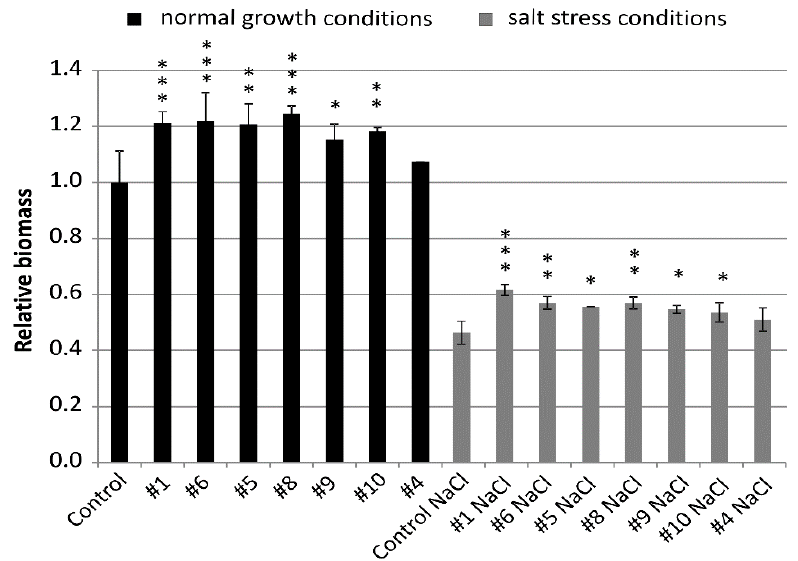
Figure 4. Relative biomass of the non-transgenic control and the transgenic plants of T 4 generation grown in normal (Hoagland medium) and in salt stress conditions (Hoagland medium supplemented with NaCl 200 mM). Data represent mean values and standard deviation of at least six plants grown in normal and salt stress conditions. Indicated are significant differences between the control and the line grown in the same conditions: * p < 0.05, ** p < 0.01, *** p < 0.001.